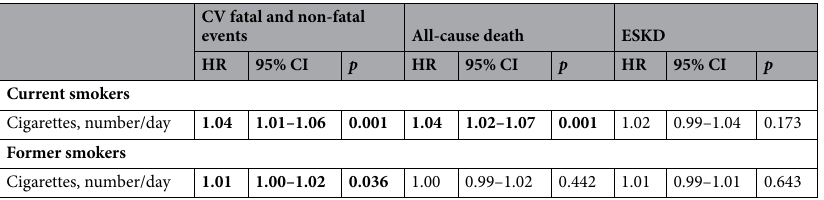
Table 5. Cardiovascular, mortality and renal risk by number of cigarettes consumed per day. Models (with current or former smokers, separately) are adjusted for all the covariates included in Table 3. HR hazard ratio, CV cardiovascular, ESKD end-stage-kidney-disease. Number of cigarettes variable was log-transformed due to the skewed distribution. Estimates with p value <0.05 are shown in bold.